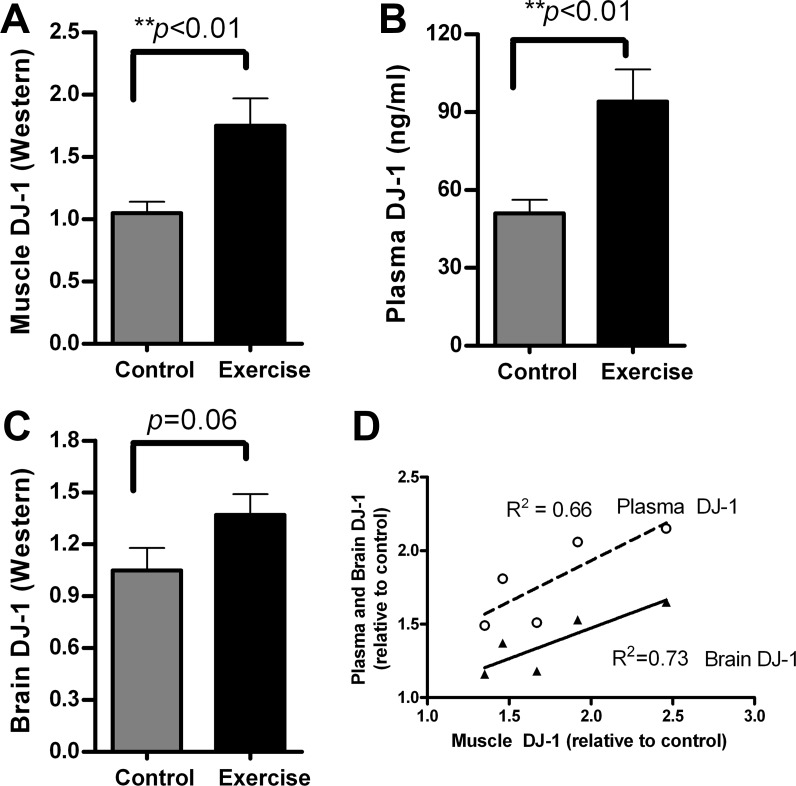
Running wheel exercise in wild-type mice increased DJ-1 expression in muscle, plasma, and brain.Adult FVB/N wild-type mice (4–6 months old) were assigned to either an exercise group or a control group (n = 5 each). After one week of running wheel exercise, animals were sacrificed and tissues collected for DJ-1 protein analysis by Western blot (muscle and brain) and ELISA (plasma). (A) Quantitative data normalized to β-actin show that muscle DJ-1 levels were significantly higher in the exercise group than controls (t-test, **p<0.01). (B) DJ-1 levels in plasma were significantly increased in exercise mice compared to control mice (t-test, **p<0.01). (C) Brain DJ-1 levels were higher in exercise mice than control mice, but not significantly (t-test, p = 0.06). (D) Correlations between muscle and plasma DJ-1 (dashed line) and brain DJ-1 (solid line) in exercising mice. Both plasma and brain DJ-1 levels were significantly correlated with the exercise-induced change in muscle DJ-1 (plasma vs. muscle, p = 0.04 and brain vs. muscle, p = 0.03). All DJ-1 values are relative to non-exercise controls.